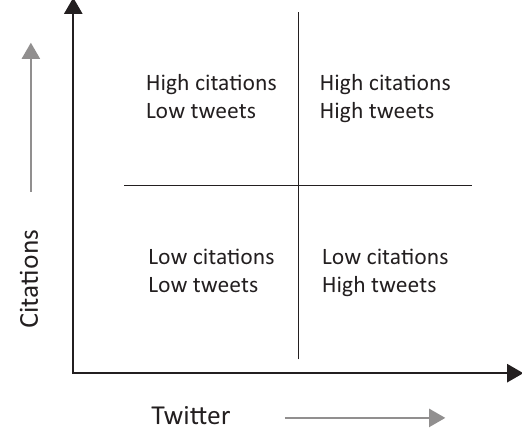
Figure 1. Faculty citation and tweet activity